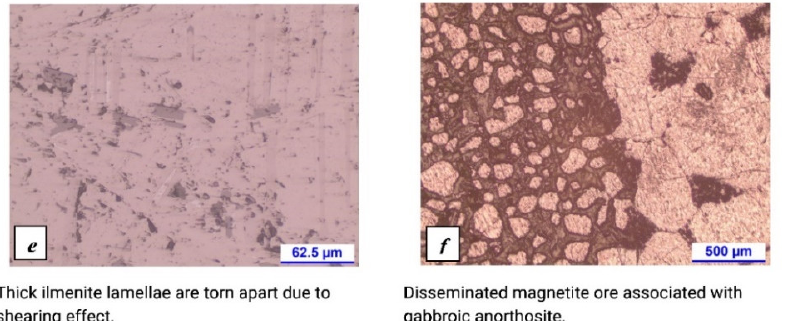
Figure 10. ( a – f ) Photomicrographs of thin cum polished section under the microscope showing Figure 10. ( a–f ) Photomicrographs of thin cum polished section under the microscope showing dif- ferent minerals and micro-structures [17]. different minerals and micro-structures [17].